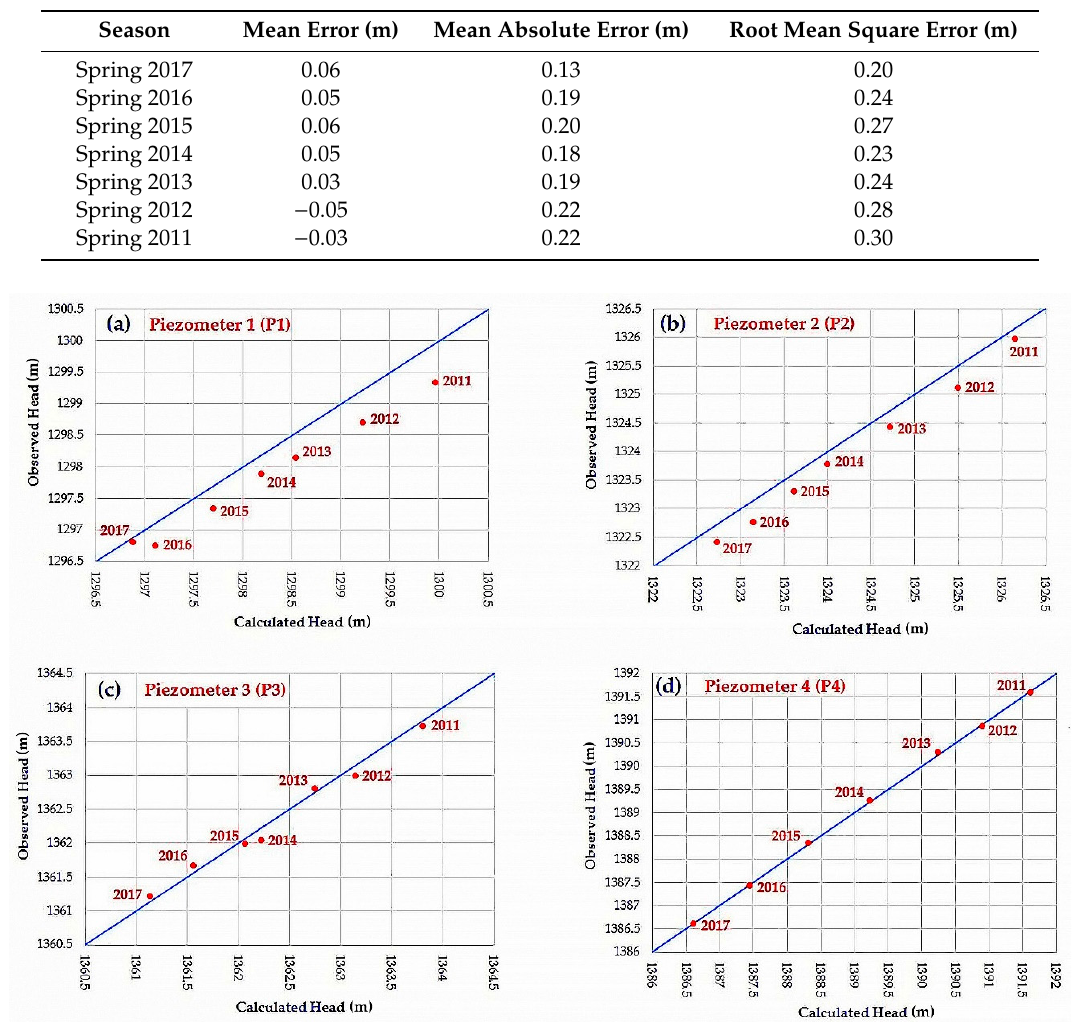
Table 3. Evaluation results of Birjand groundwater model over a 7-year period.